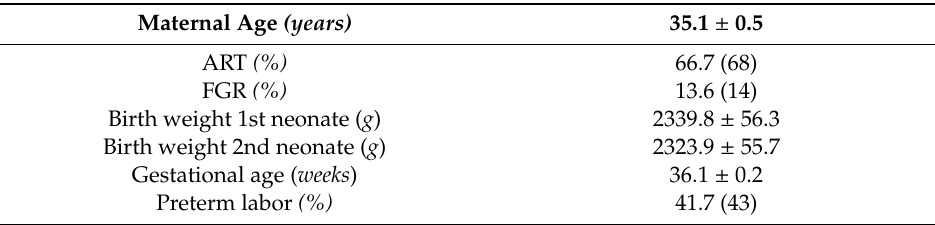
Table 1. Maternal and neonatal characteristics of the